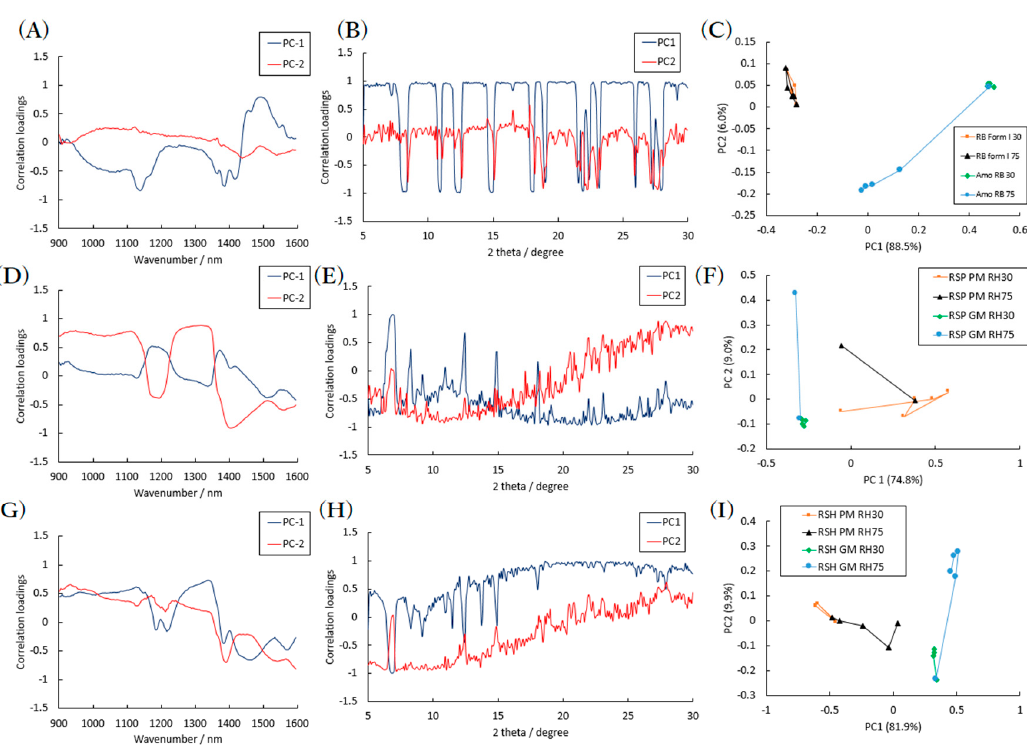
Cal; calibration model. Val; validation modes. Dif; cumulative percentage variance difference between one lower component model and the models on validation models. RB; rebamipide. NIR; near-infrared. PCA; principal component analysis.